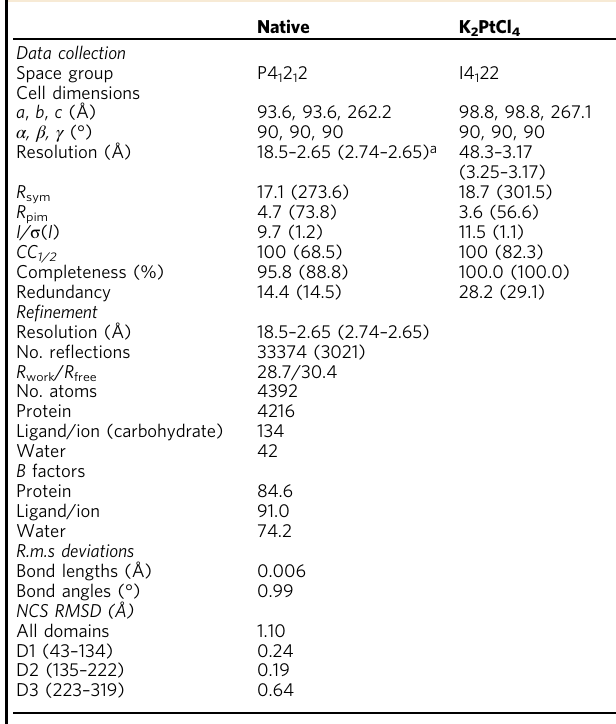
Table 1 Data collection, phasing, and re fi nement